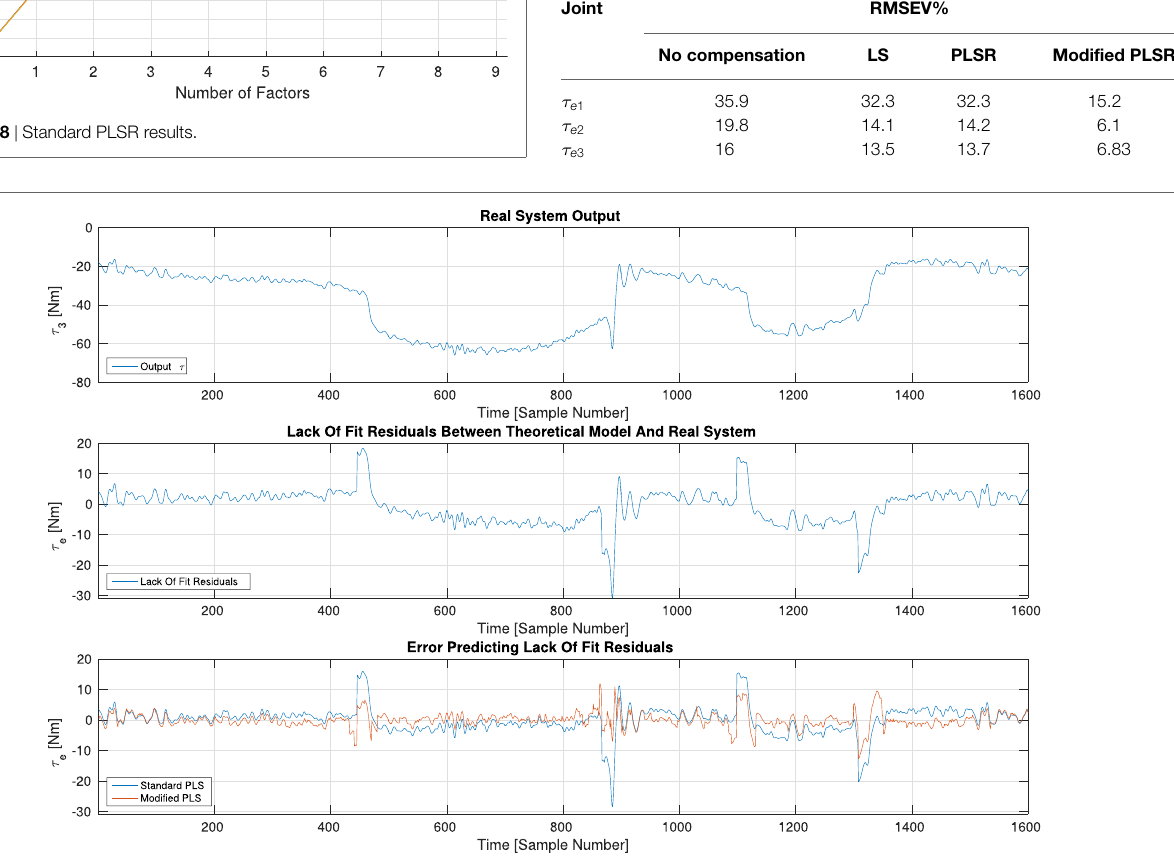
FIGURE 9 | Illustrative result to complement Table 1